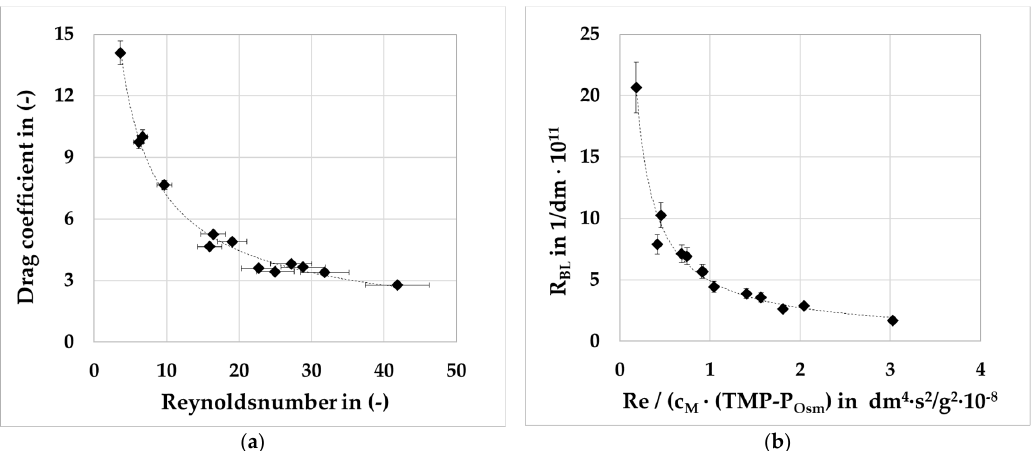
Figure 6. Parameter determination curves for ( a ) drag factor coefficients with R 2 0.98 and ( b ) boundary layer resistance with R 2 0.97.